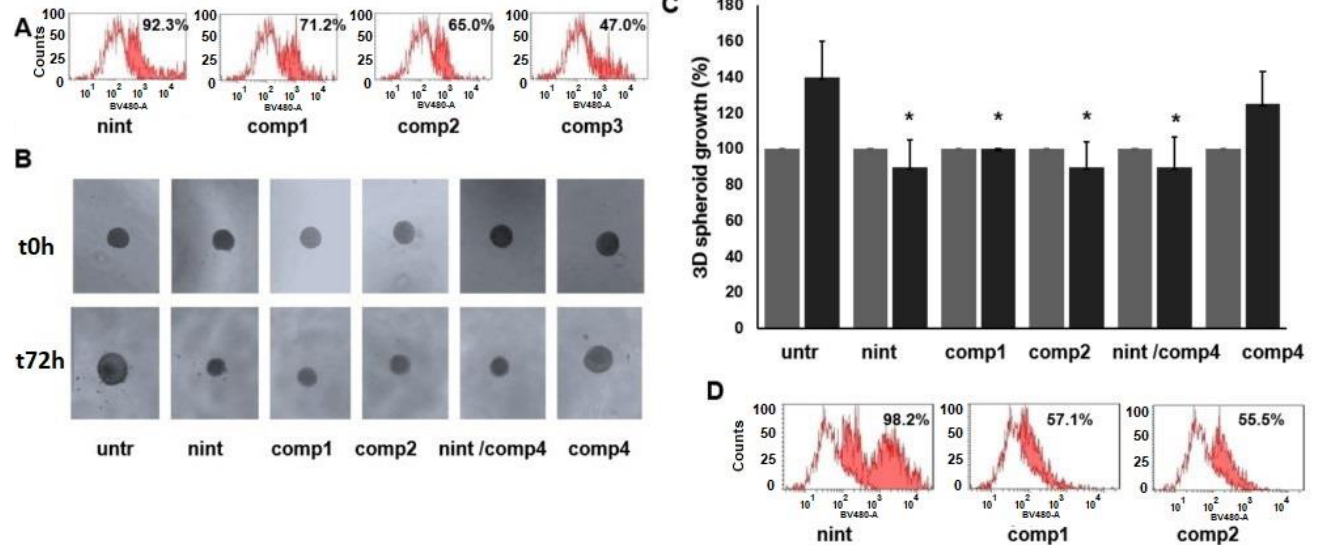
Figure 7. Inhibition of tumor spheroid growth. Hanging drop tumor spheroids were prepared starting from 1:1 mixed cell population (1000 cells/25 µ L) of TGF β -treated A549 cells and murine L929 fibroblasts. ( A ) 3D spheroid internalization after the exposure to nintedanib, compounds 1 , 2 , or 3 (at 5 µ M). ( B ) Representative images of inhibition of 3D spheroid growth after the exposure to nintedanib, compounds 1 , 2 , the combination of compound 4 with nintedanib or compound 4 . ( C ) Quantitative analysis of inhibition of 3D growth and ( D ) 3D spheroid internalization of the compounds after 72 h exposure. Data are representative of three independent experiments ( n = 6) and expressed as means ± SEM. * p < 0.05 vs. untreated spheroids.